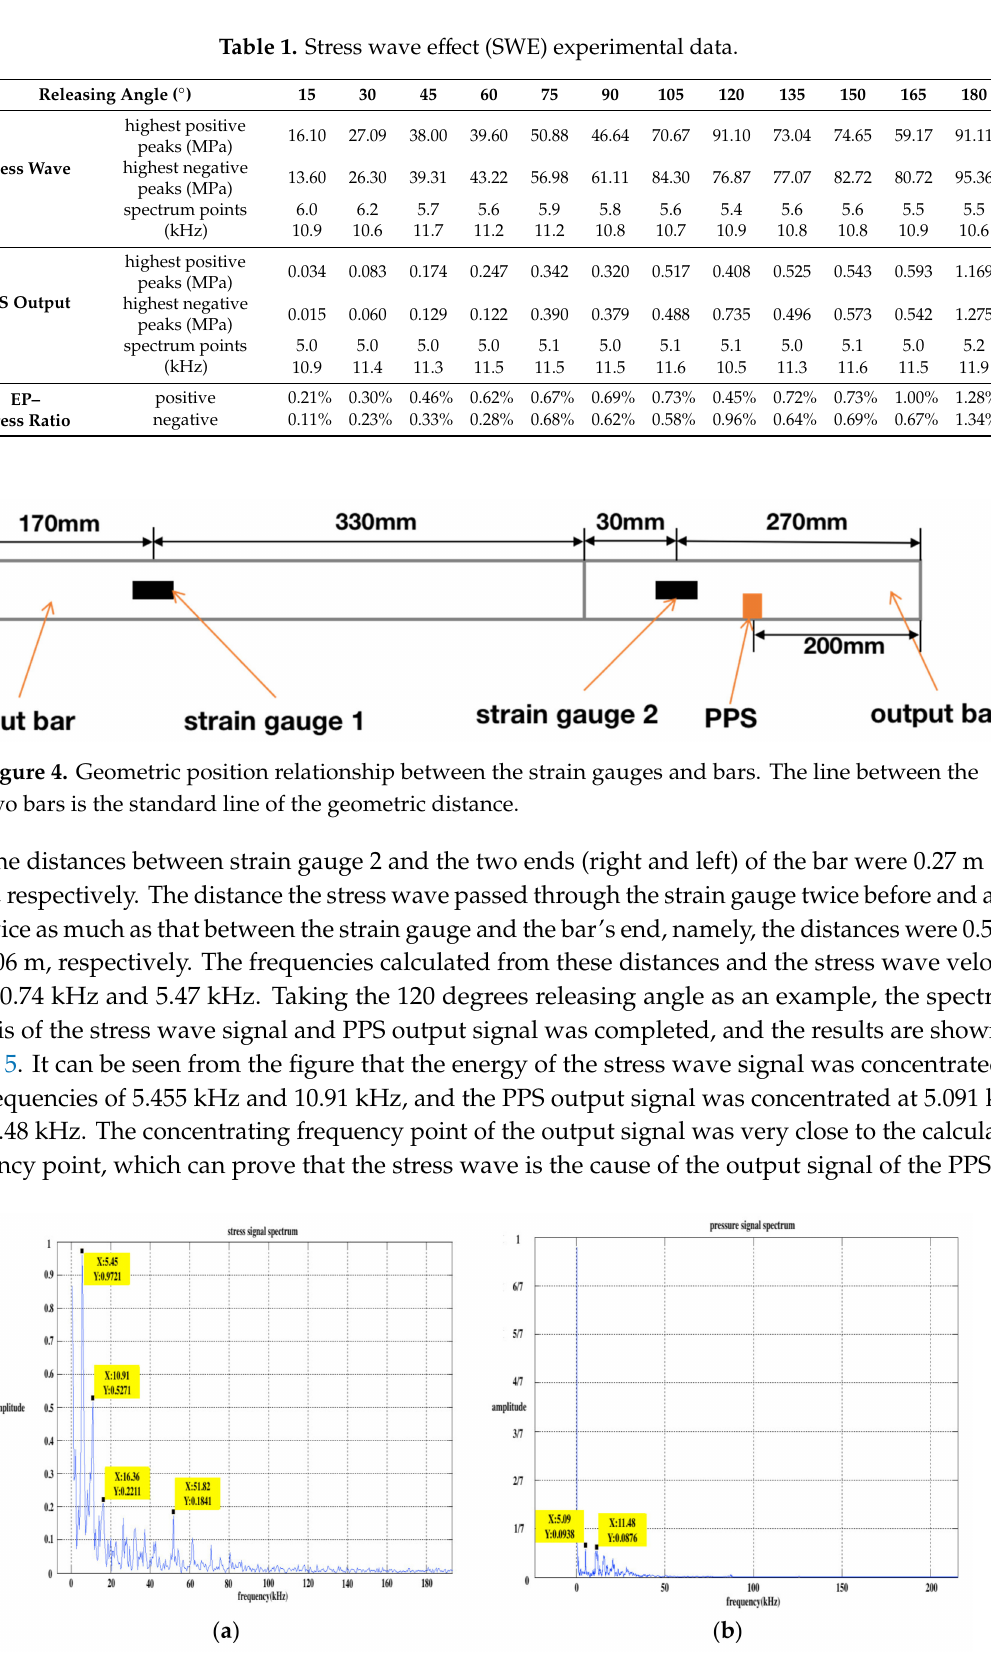
Figure 5. Spectrum of two signals at 120 degrees: ( a ) spectrum of the stress wave signal; ( b ) spectrum of the PPS output